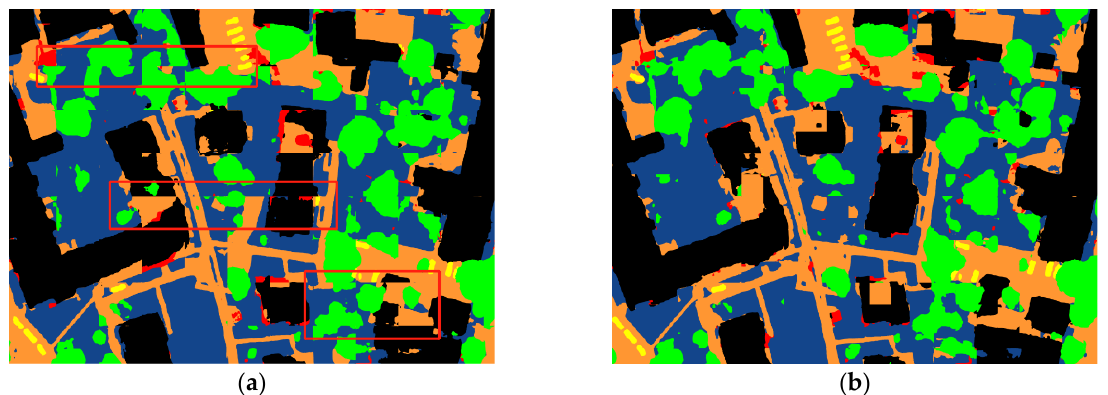
Figure 12. Examples of the results of two datasets optimized by EPCP, respectively, where the red boxes mark the splice traces: ( a ) unoptimized results and ( b ) optimized results.